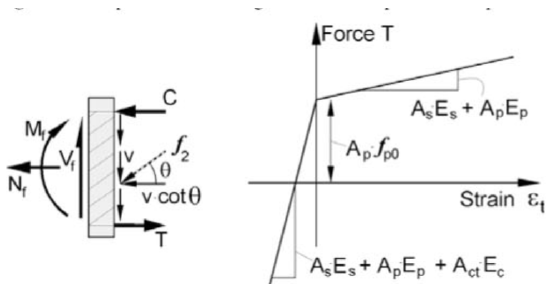
Figure 12: Acting and resisting forces and strains on a section